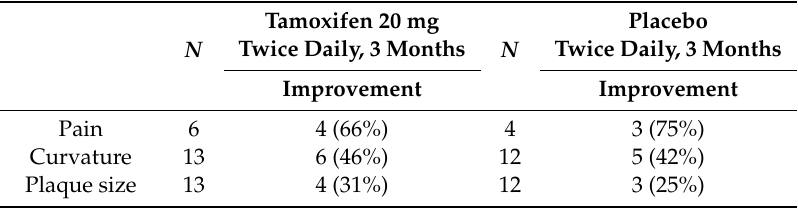
Table 12. Tamoxifen vs. Placebo: Randomized, Double-Blind, Placebo-Controlled.